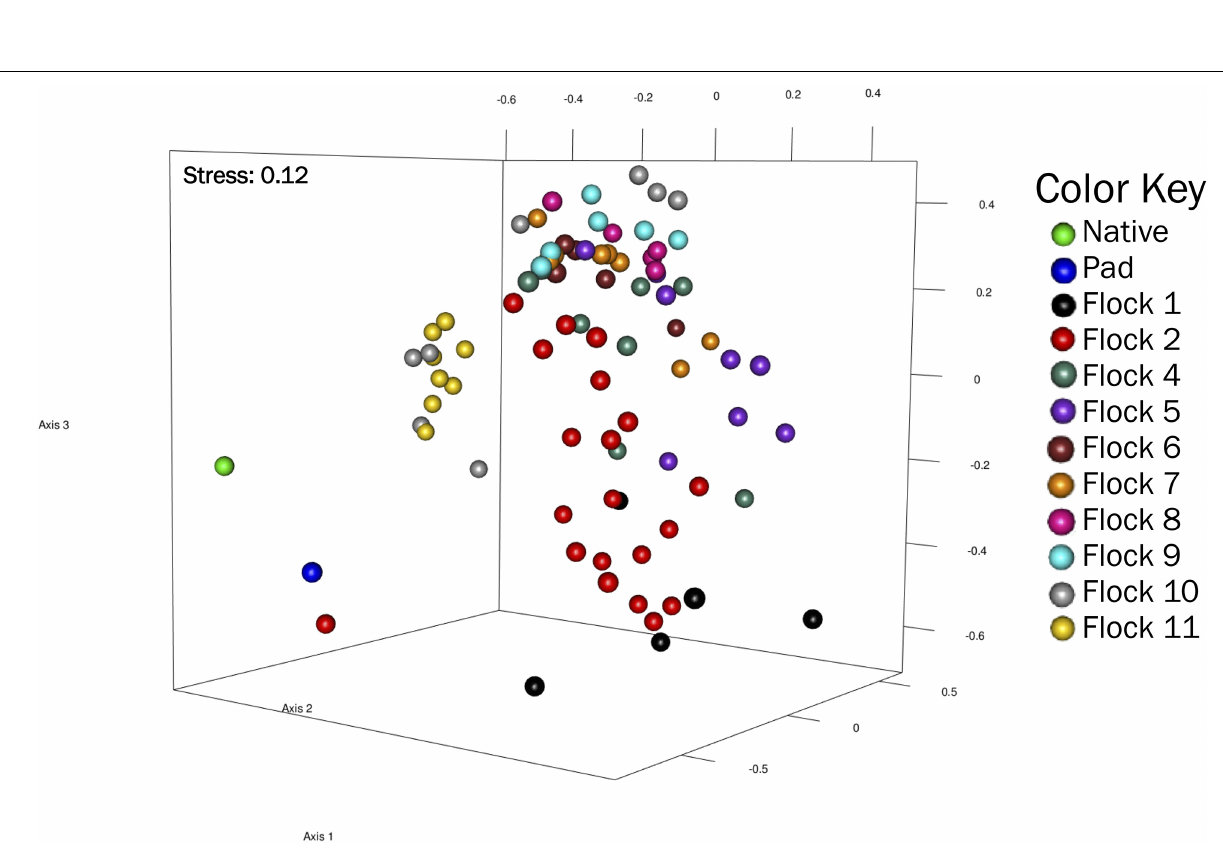
Frontiers in Microbiology |